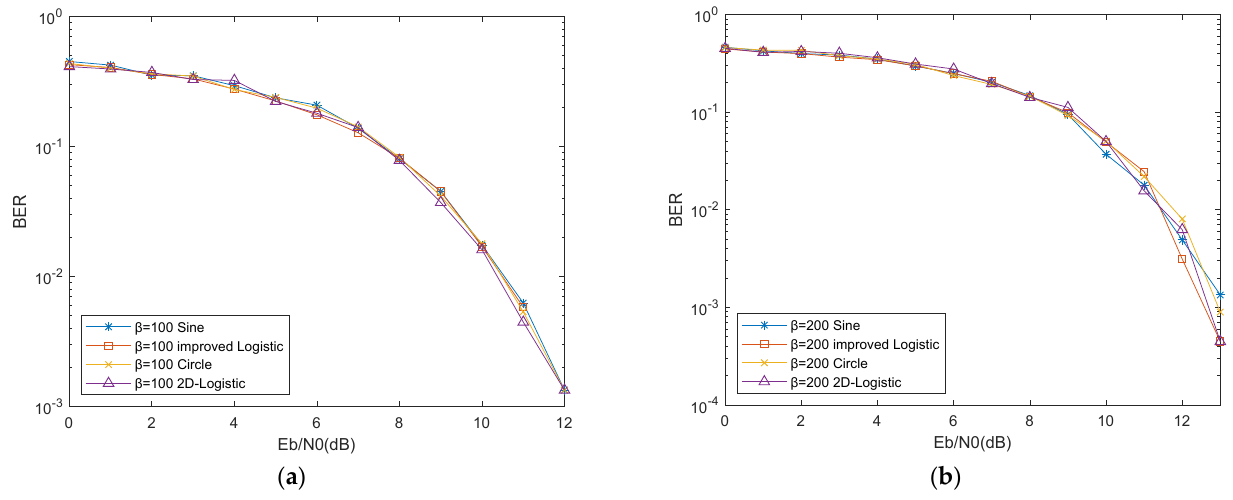
Figure 9. BER curves of the system with different chaos maps. ( a ) β = 100, x 0 = 0.40; ( b ) β = 200, x 0 = 0.40.